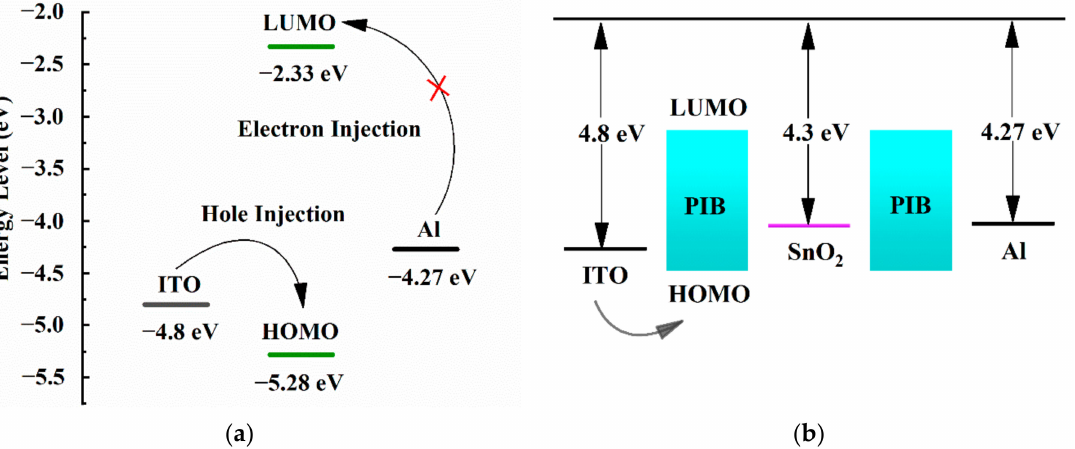
Figure 8. ( a ) Energy level diagram and electron migration process of ITO/PIB/Al. ( b ) Energy level diagram and electron migration process of ITO/PIB: SnO 2